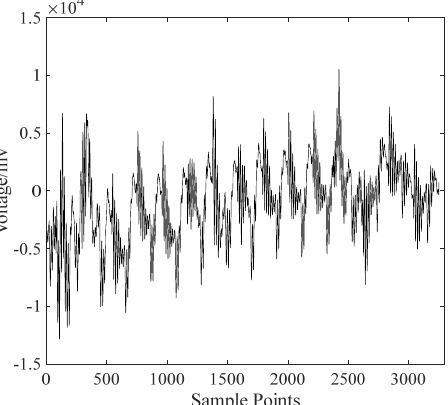
Figure 7. A piece of power trace collected from the FPGA platform.